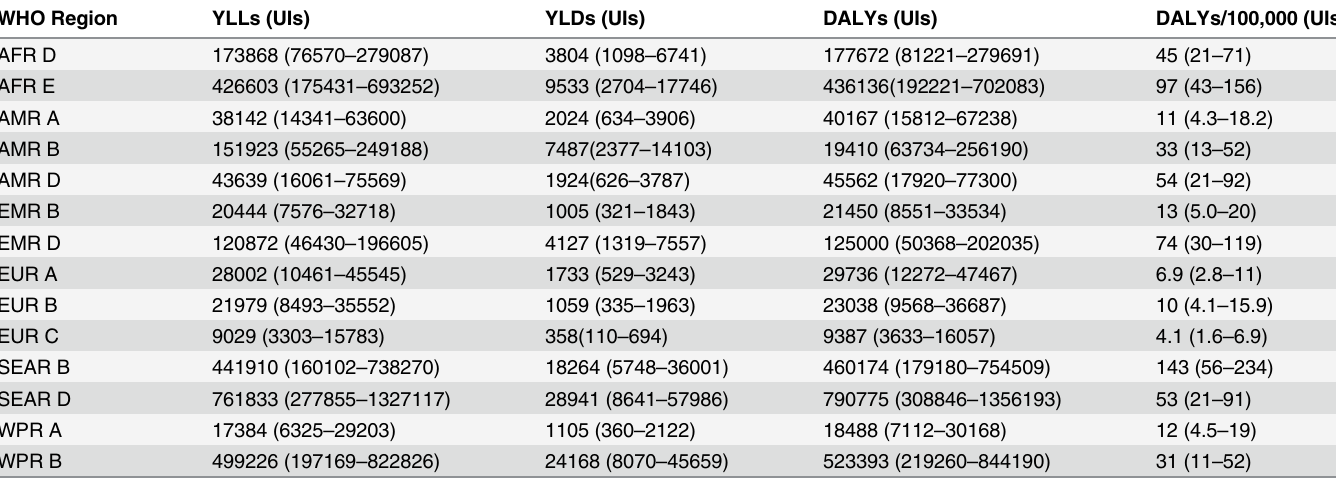
Table 3. Annual burden of disease due to leptospirosis by WHO region.